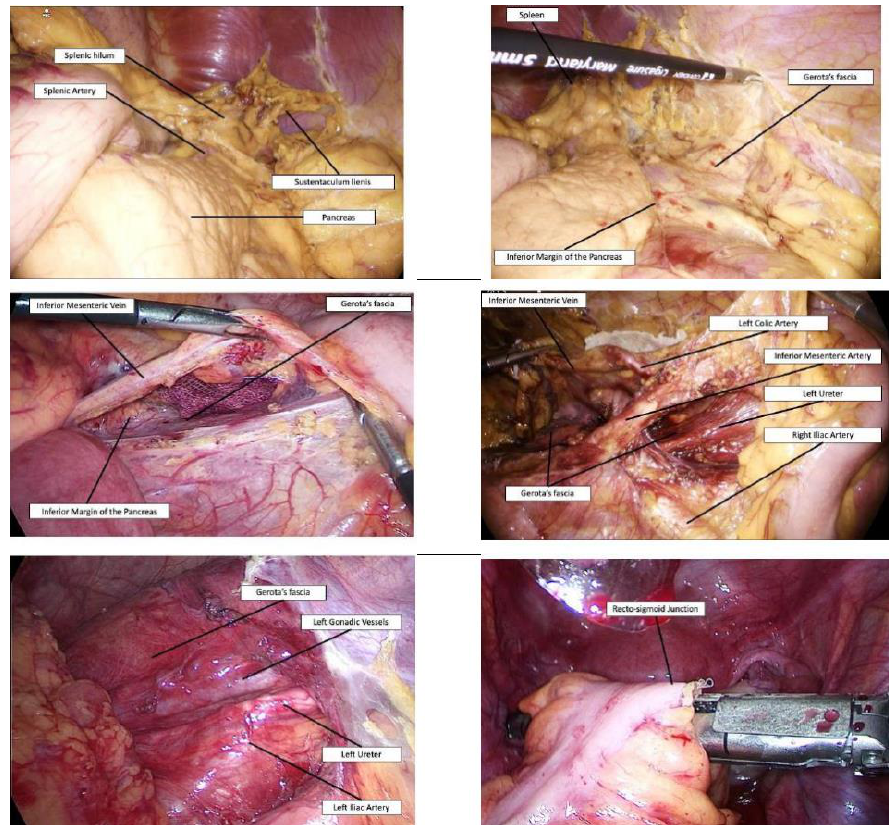
Figure 1. Upper panel: Critical-view I (left) and II (right). Middle panel: Critical-view II (left) and III (right). Lower panel: Critical-view IV (left) and rectosigmoid division (right).